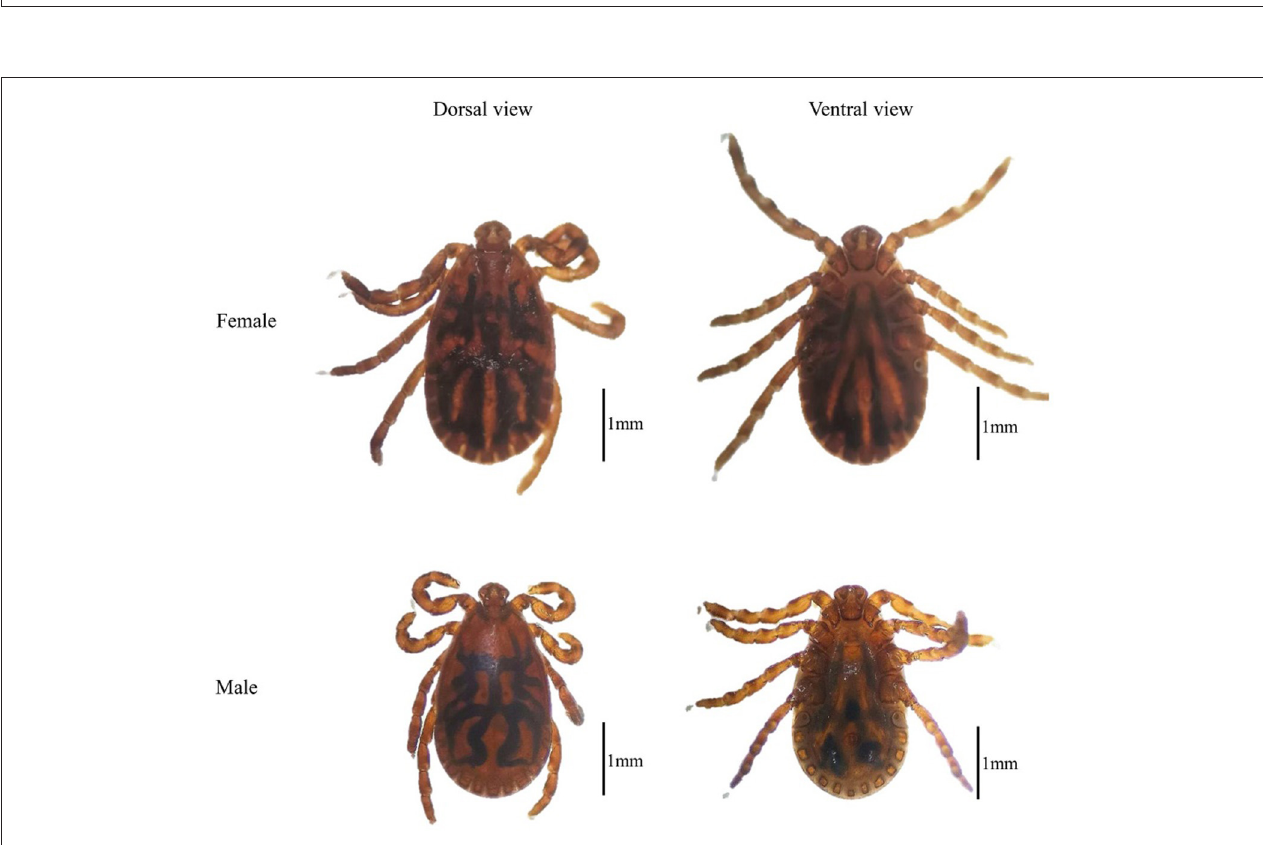
FIGURE 1 | Map of the Qinghai–Tibetan Plateau Area and Qinghai Province showing the sampling sites. The green hollow circle indicates the location of the sample collection in this study.